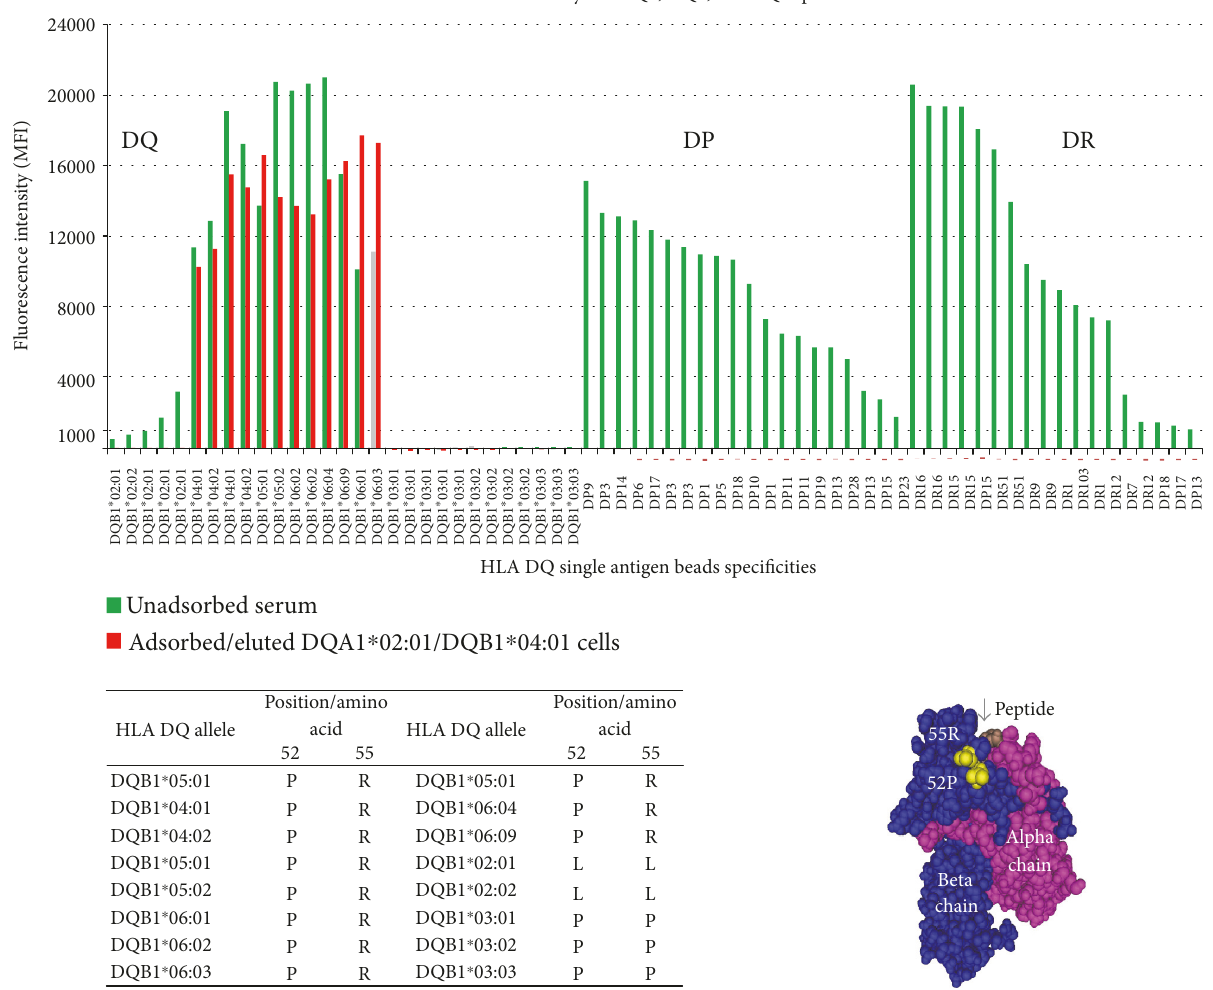
Figure 12: Unabsorbed serum has antibodies with speci fi city to DR, DQ, and DP antigens (green bars). After adsorbing the serum with rHLA DQ cells, the eluted antibody shows speci fi city to DQ antigens only (red